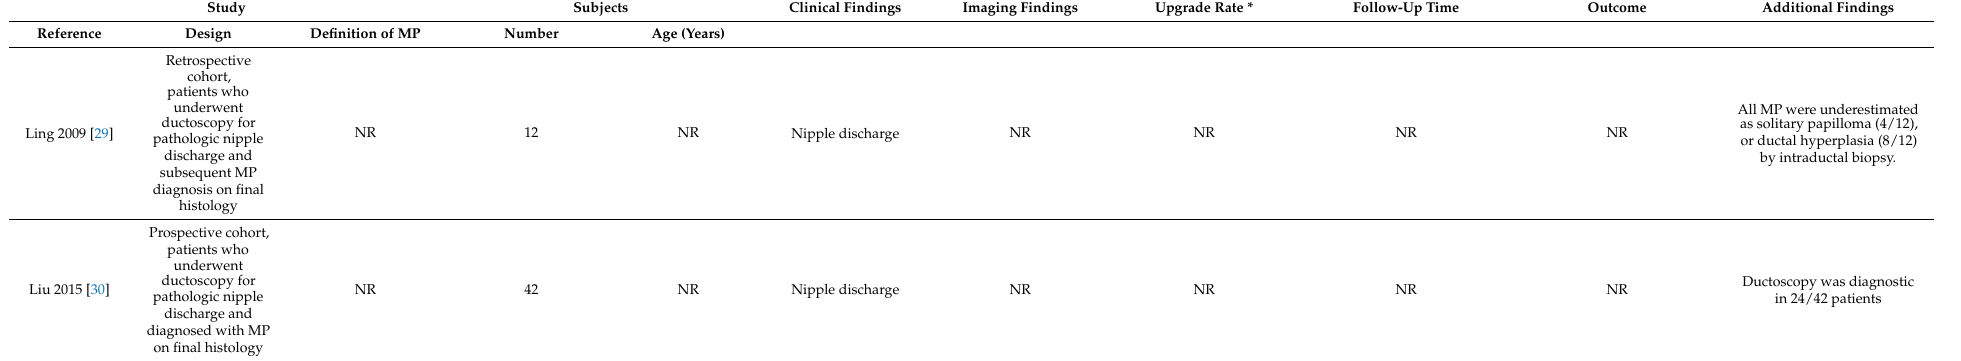
Abbreviations: ADH, atypical ductal hyperplasia; ALH, atypical lobular hyperplasia; BC, breast cancer; 95%CI, 95% confidence interval; CNB, core needle biopsy; DCIS, ductal carcinoma in situ; FEA, flat epithelial atypia; FNA, fine needle aspiration; FUP, follow-up; IDP, intraductal papilloma; LCIS, lobular carcinoma in situ; LIN, lobular intraepithelial neoplasia; MP, multiple papillomas; MRI, magnetic resonance imaging; MX, mammography; NR, not reported; OR, odds ratio; R, recurrence; RR, relative risk; RS, radial scar; SE, surgical excision; SD, standard deviation; TDLU, terminal duct lobular unit; US, ultrasound; VAB, vacuum assisted biopsy. * Upgrade rate: was defined as the proportion of lesions initially diagnosed as benign papillomas and found atypical or classified as DCIS or invasive cancer after VAB or surgical